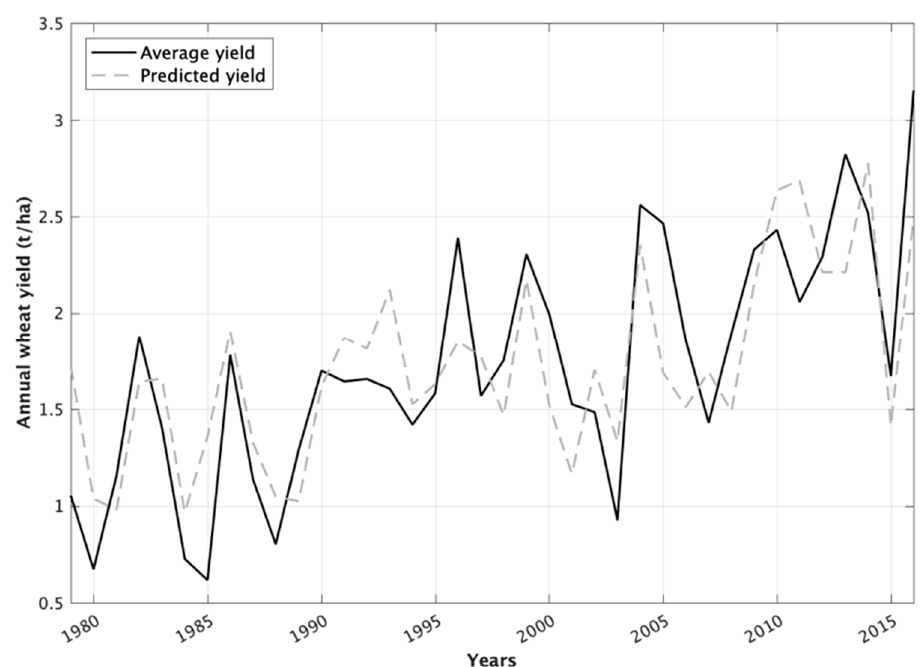
Figure 14. Average vs. predicted yield for rural municipality # 100 (1979–2016) (Dark Brown soil zone).